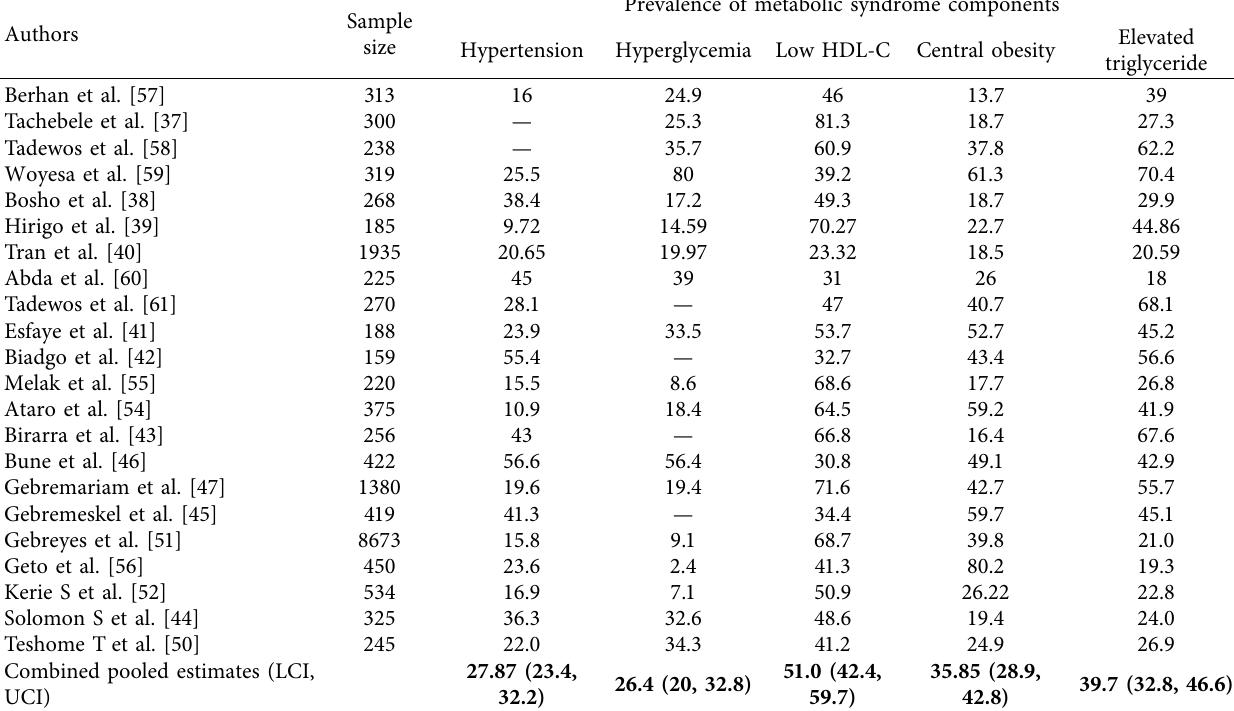
Table 5: Pooled estimates of metabolic syndrome